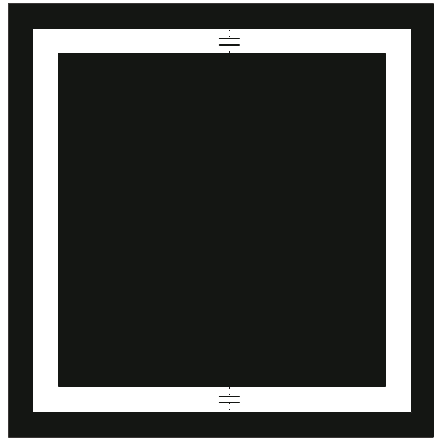
Figure 2: Square loop aperture